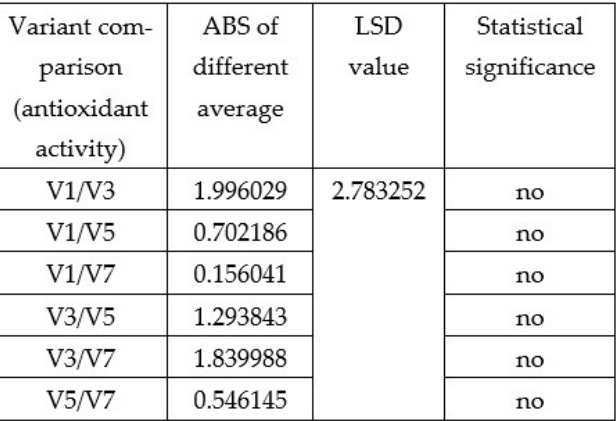
Figure 10. The statistical significance determined by LSD (Least Significant Difference) test values of flavonoid concentration in Lepidium sativum L. sprouts cultivated on gauze (V1 control, illumi ‐ nated with sunlight; V3, illuminated with white LED; V5, illuminated with blue LED; and V7, illu ‐ minated with red LED experimental variant), t crit value = 2.306004.